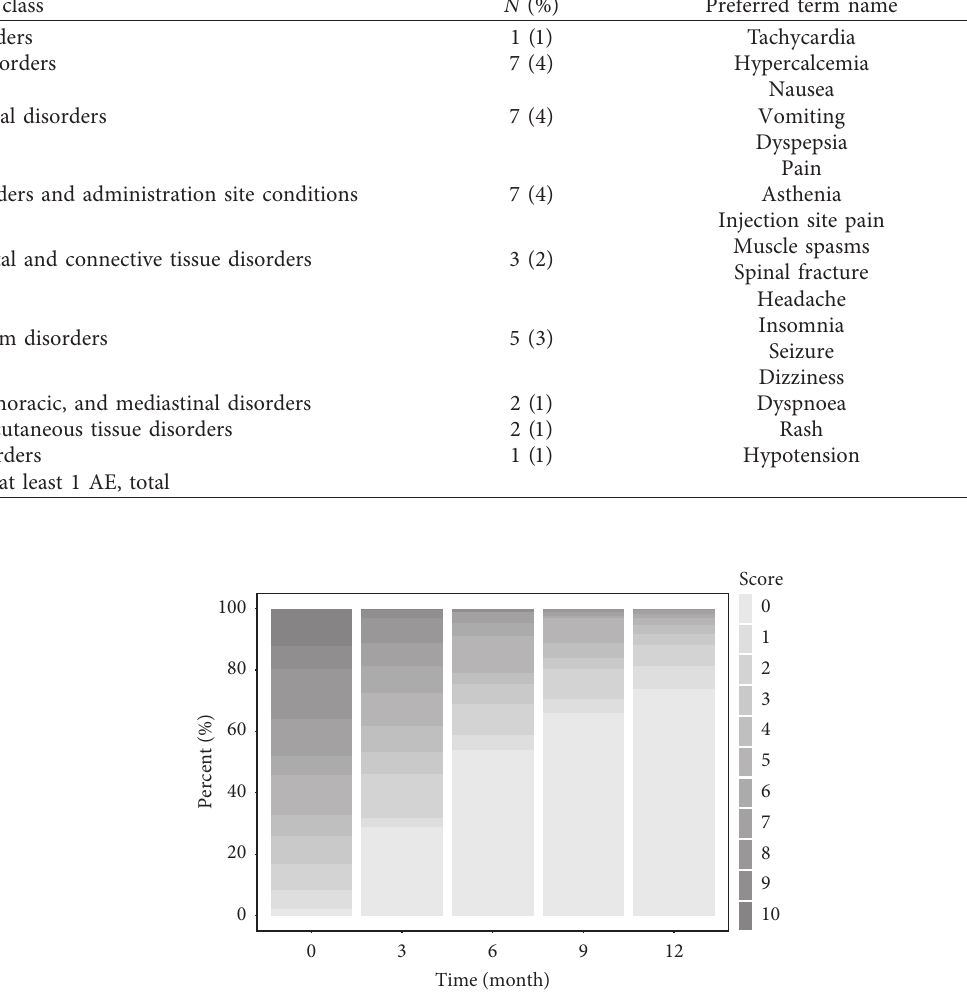
Figure 1: Back pain VAS score during the study. The darker the color, the higher the mean back pain VAS score. Table 3: Comparison of some of the AEs with other studies (in